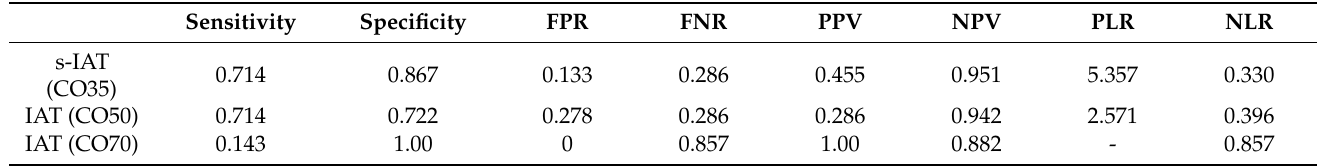
Table 3. Diagnostic characteristics of the s-IAT and the IAT at different cut-off scores. Sensitivity